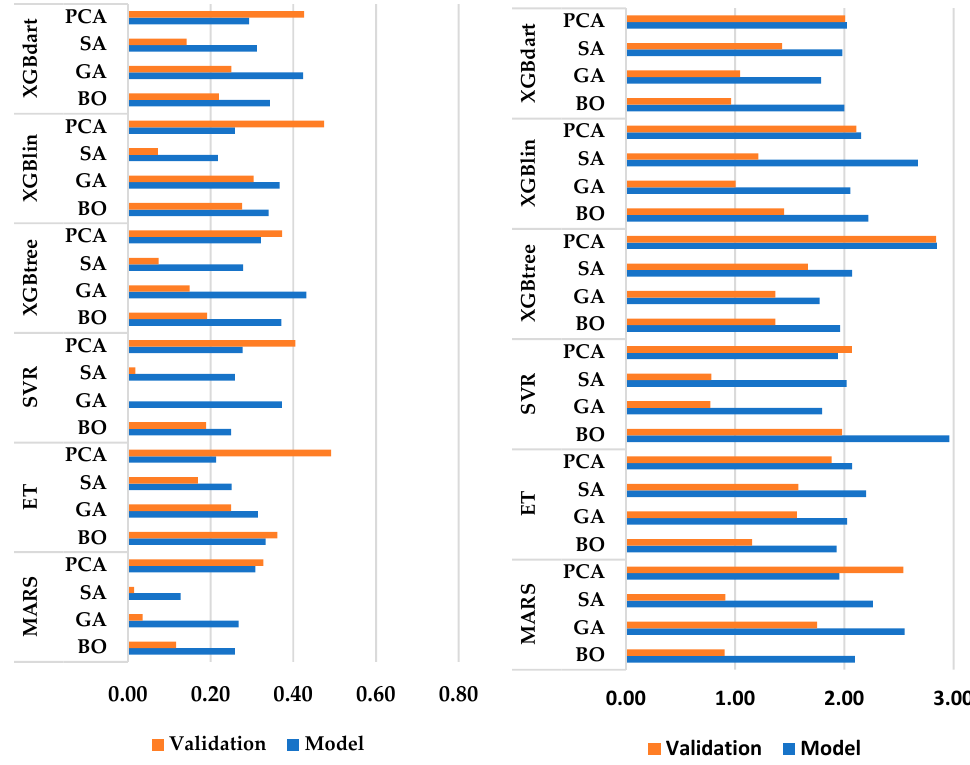
Figure 7. Machine learning model performance of R 2 ( left ) and RMSE ( right ) using input dataset from selected hyperspectral band.